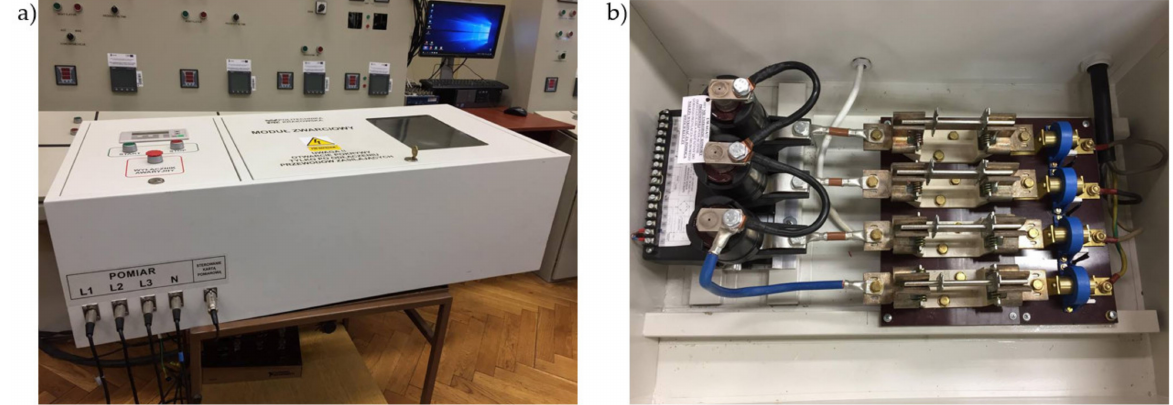
Figure 3. The outside ( a ) and inside ( b ) view on the short-circuit